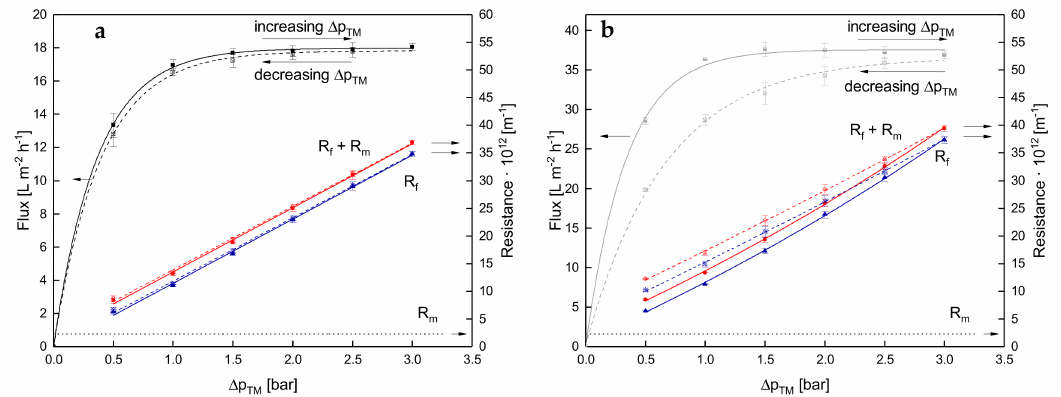
Figure 5. Flux and filtration resistances as a function of ∆ p TM for one cycle of a stepwise increase of ∆ p TM (filled symbols and solid lines) and the subsequent stepwise reduction of and dashed lines) at 10 ◦ C ( a ) and 50 ◦ C ( b ). Error bars represent the standard deviation of the flux and resistance values of two individual experiments with milk from two di ff erent